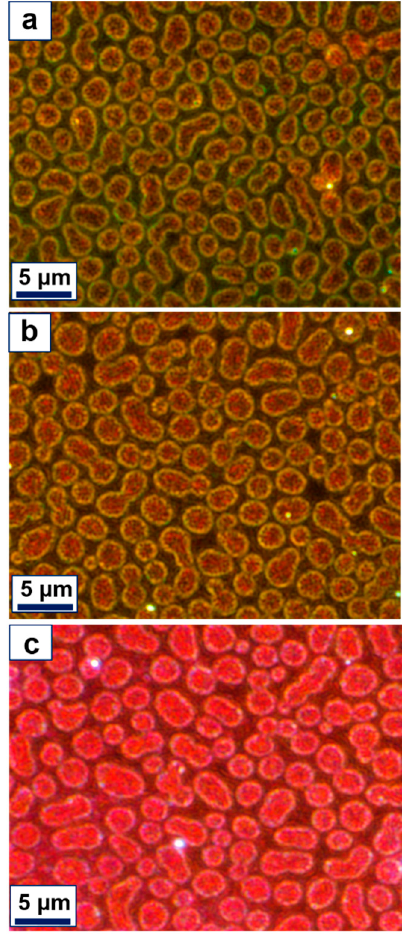
Figure 8. Dark-field optical microscopic images for ( a ) Sample A; ( b ) Sample B; and ( c ) Sample C.